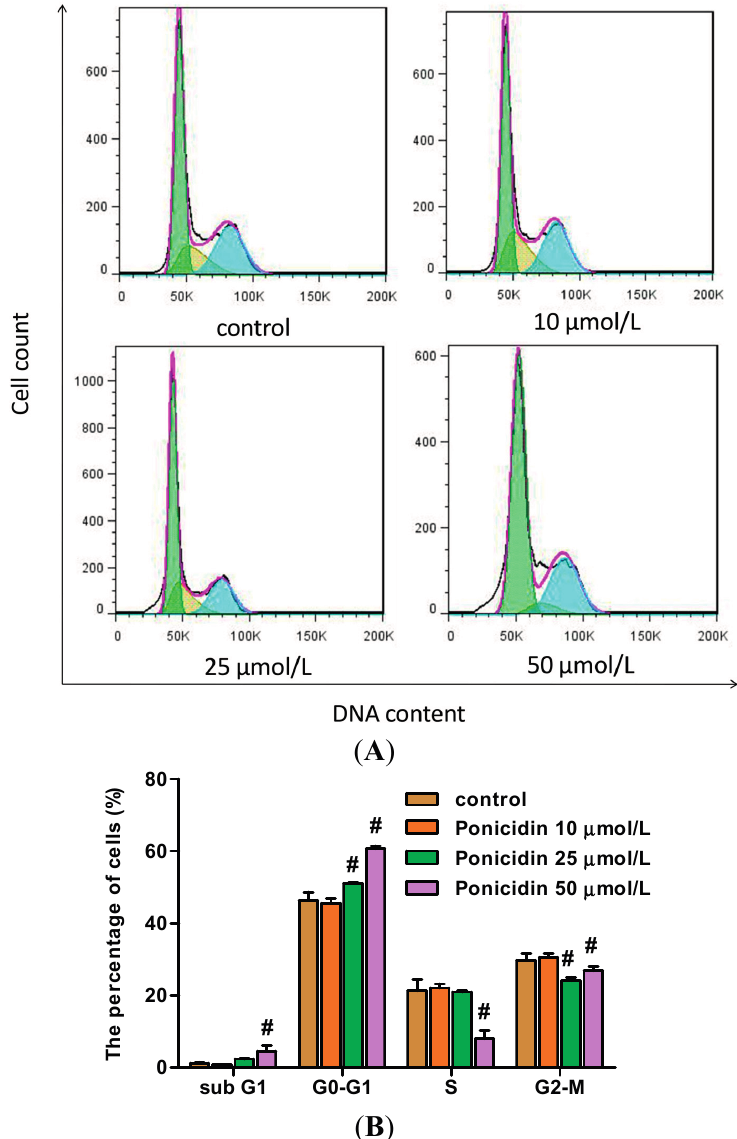
Figure 3. Effects of ponicidin on the cell cycle of MKN28 cells. ( A ) PI stain assay and flow cytometry were carried out to analyze the cell cycle after MKN28 cells were treated with ponicidin at the dose of 10, 25 and 50 μ mol/L for 48 h; and ( B ) The percentages of sub